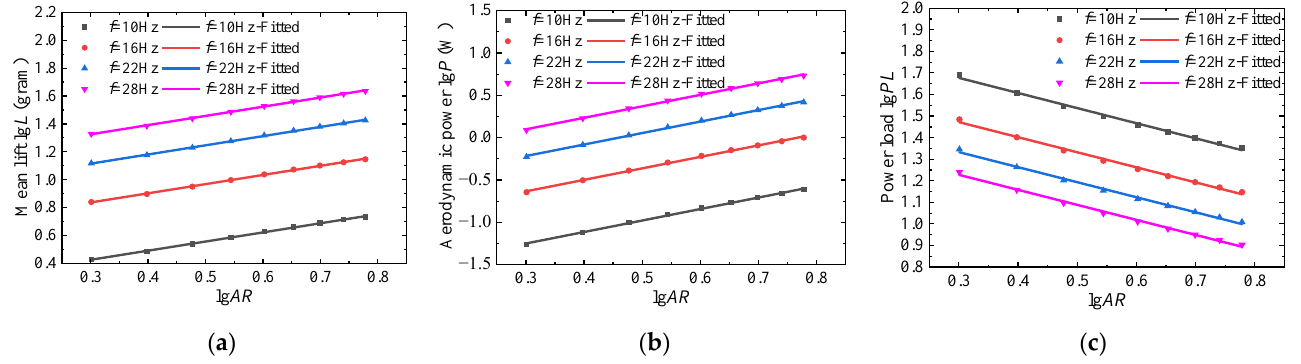
Figure 6. Logarithmic relationship of aerodynamic performance with AR . Symbols are raw data, and solid lines are fitted data. ( a ) Mean lift with AR . ( b ) Aerodynamic power with AR . ( c ) Power loading with AR . Table 5. Coefficients for the power relationship between aerodynamic performance and AR at different flapping frequencies.